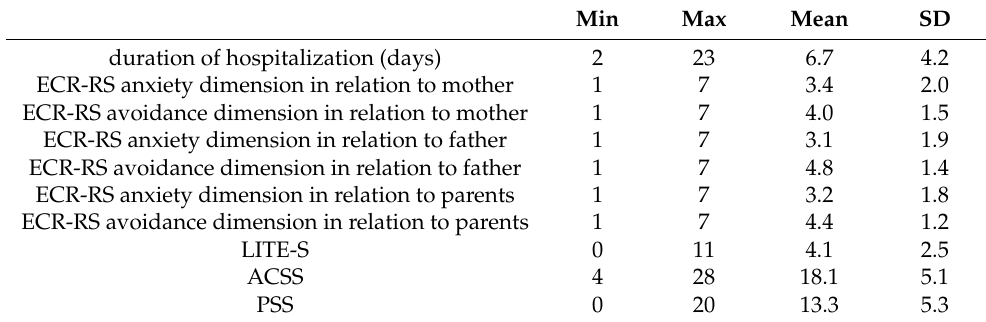
Table 3. Descriptive statistics of the